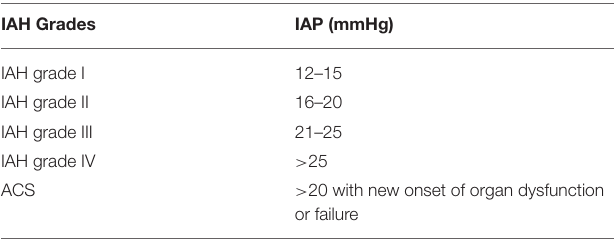
TABLE 1 | World Society of Abdominal Compartment Syndrome (WSACS) consensus definitions on the grading of IAH and